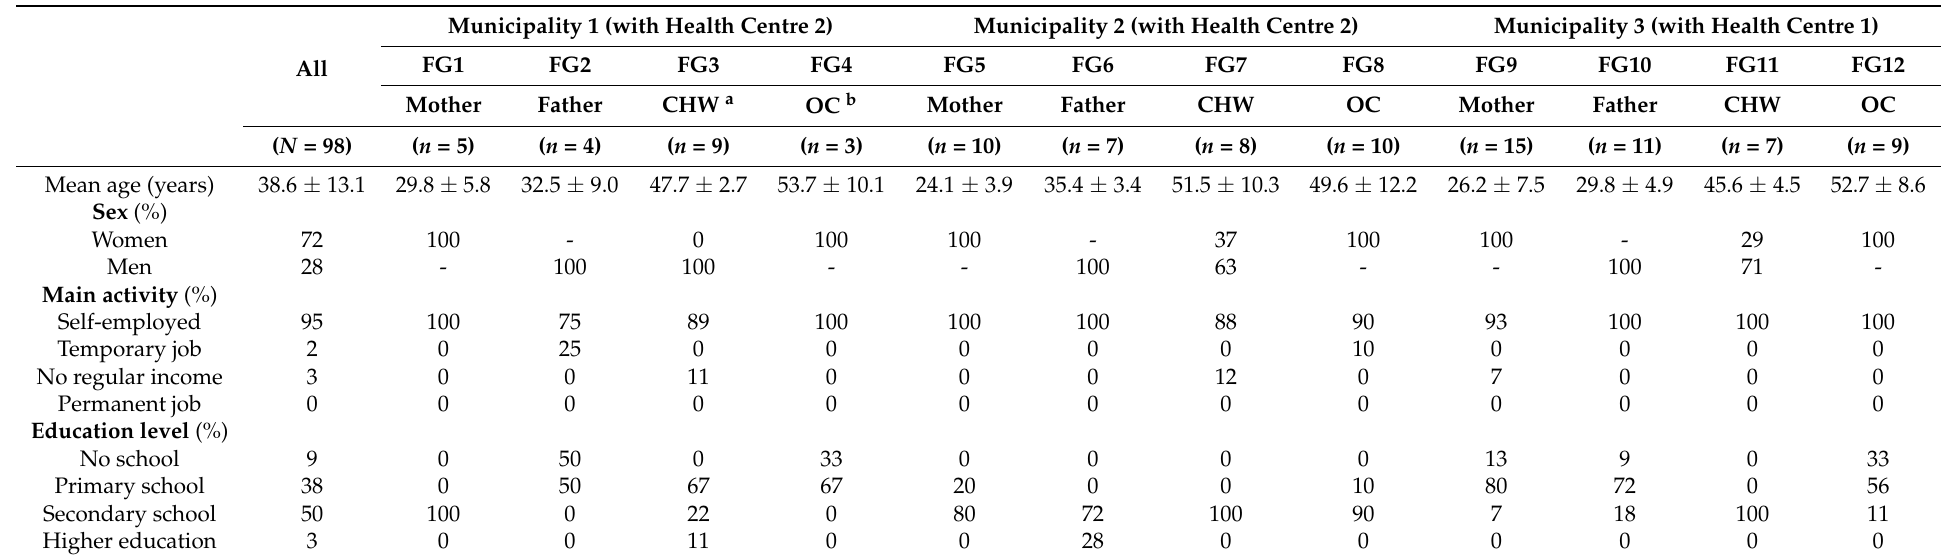
Table 9. Main characteristics of the focus group